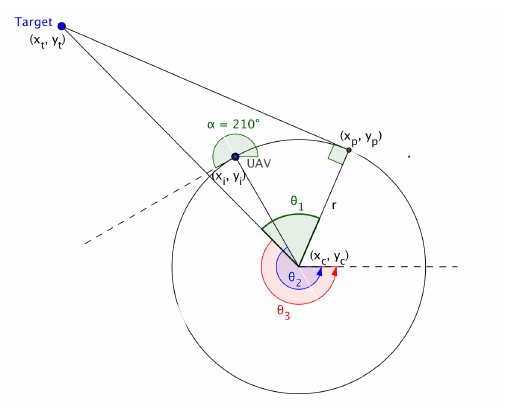
Figure 4. Dubins longest